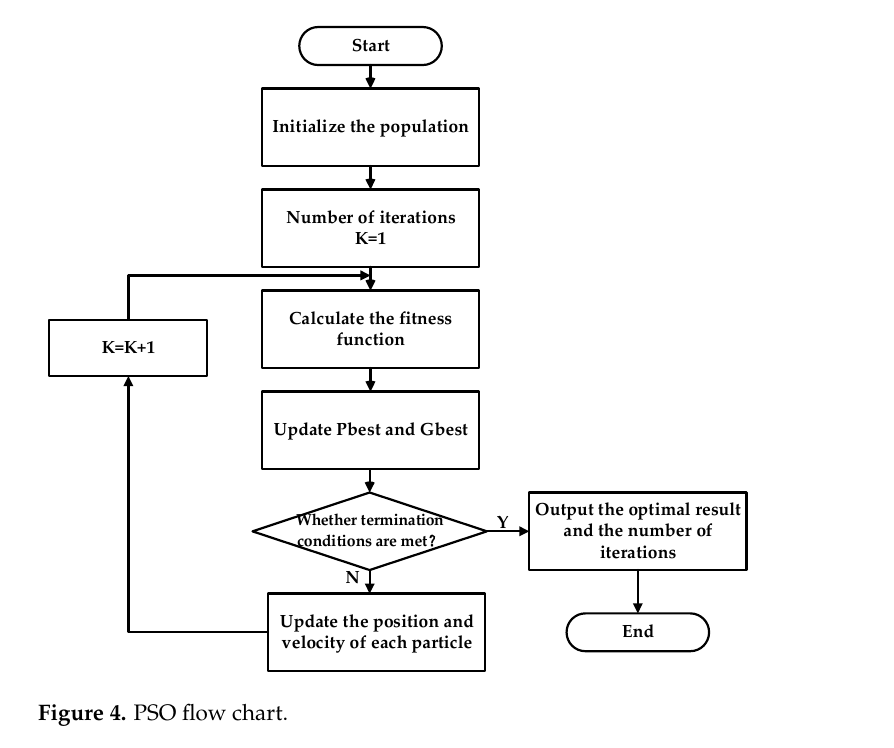
Figure 4. PSO flow chart.